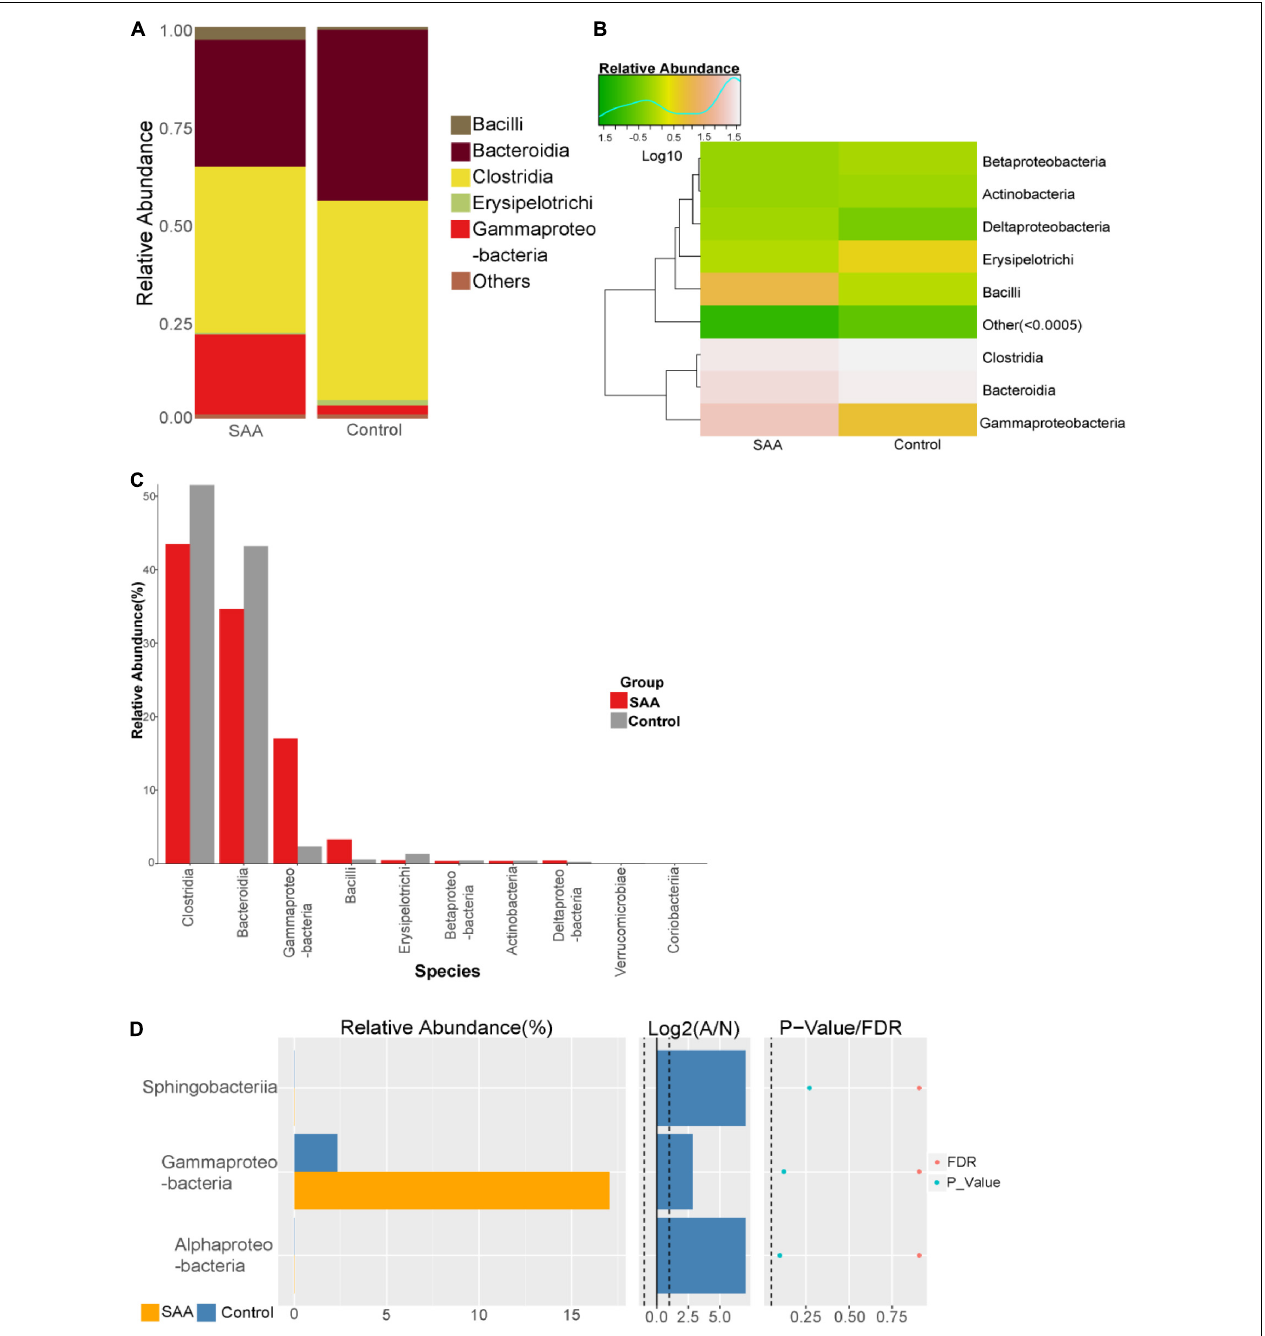
FIGURE 4 | Intestinal microbial compositions of the SAA and control groups at the class level. (A) Bar plot, (B) heatmap, (C) top 10 most abundant species, (D) Wilcoxon rank-sum test